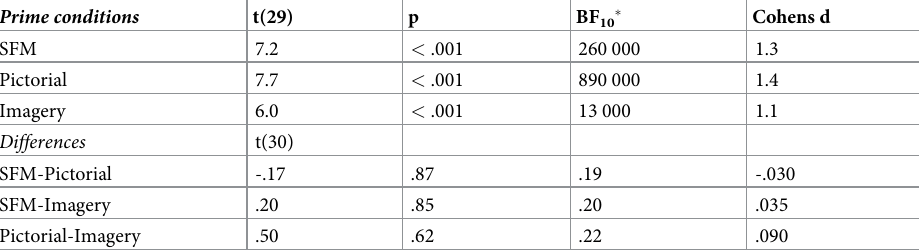
Table 3. Influence of primes and differences between primes in Experiment